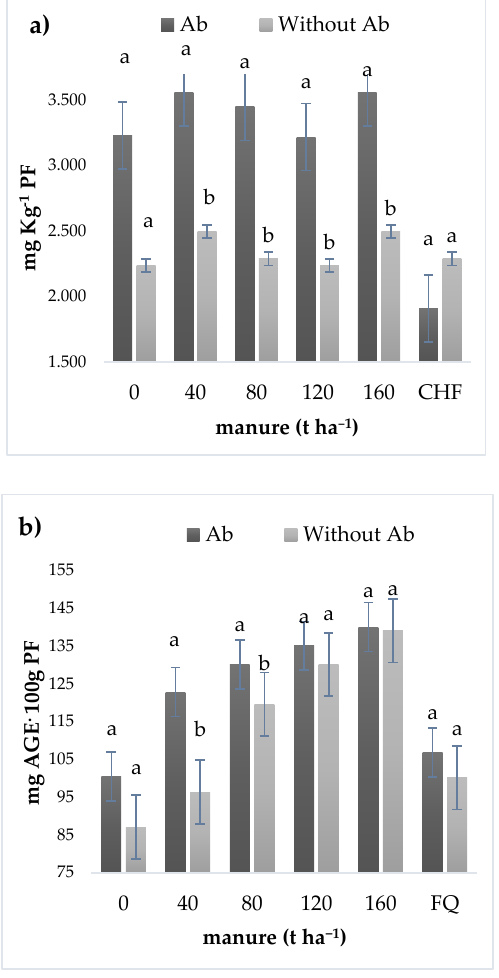
Figure 4. Interaction of Ab–Fertilization in lycopene ( a ) and phenols ( b ) in tomato fruit. Ab: Azospirillum brasilense ; 0, 40, 80, 120, 160 = manure t . ha −1 ; CHF: chemical fertilization. Different literals in the bars indicate significant difference with p <0.05.